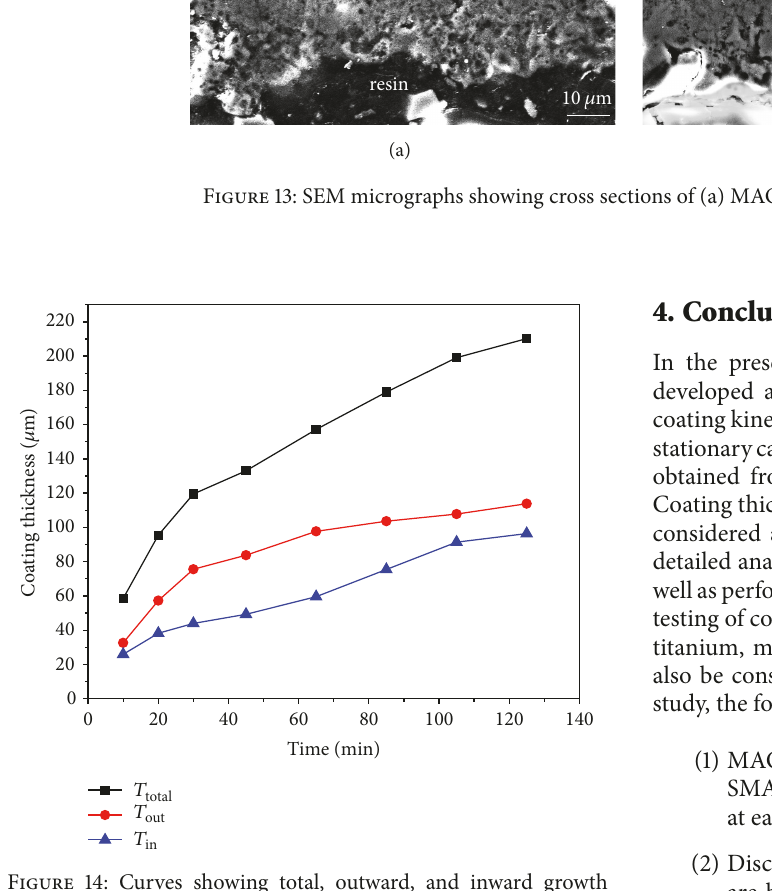
Figure 14: Curves showing total, outward, and inward growth behavior of the SMAO coating as a function of time on A356 substrate at AC1, interelectrode gap 5mm, and stationary nozzle using a Na 2 SiO 3 +NaOH electrolyte